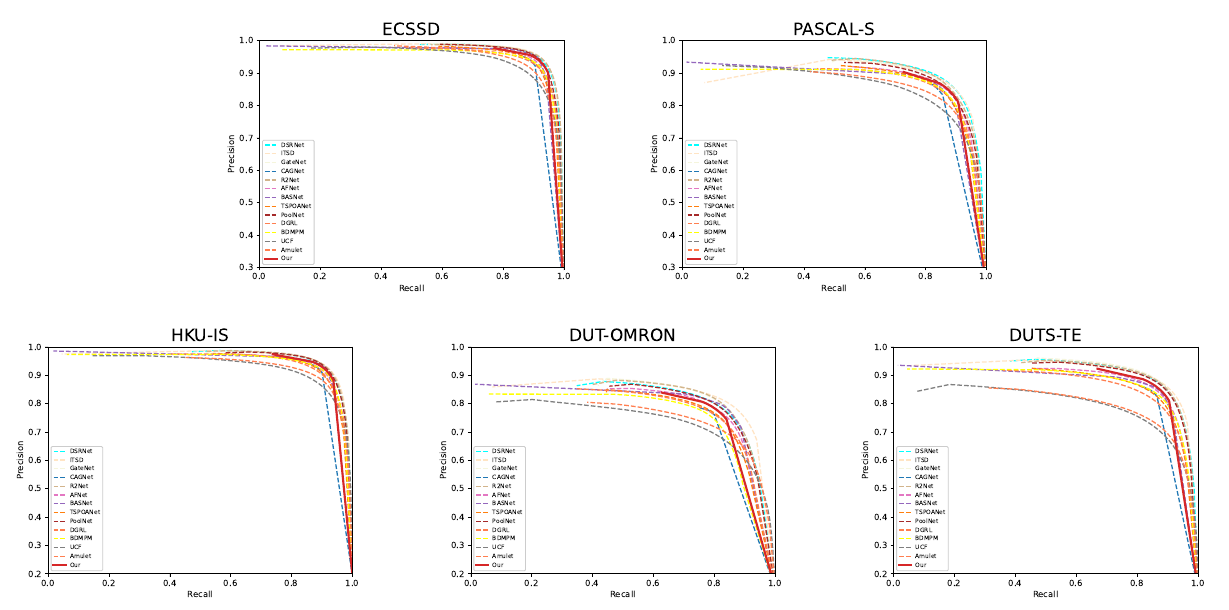
Figure 5. Quantitative results of PR curves for GSCINet and other SOD methods on the five saliency detection datasets.